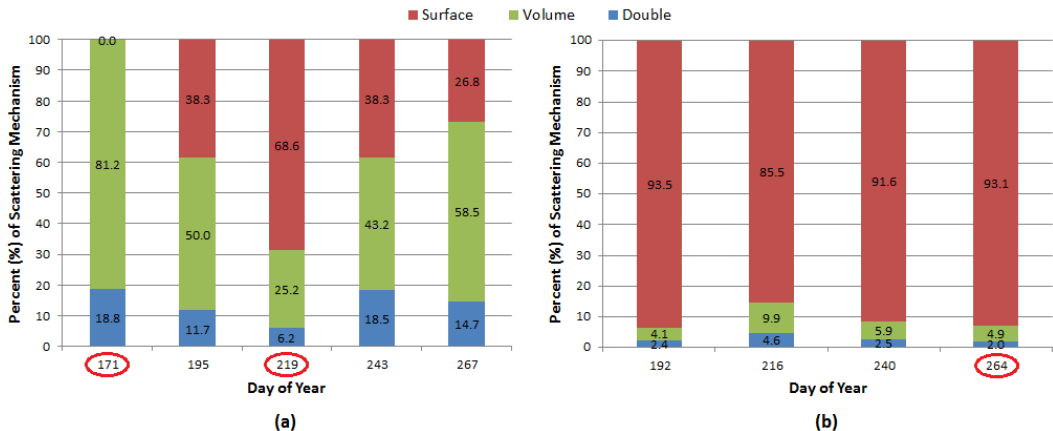
Figure 14. Surface water Freeman-Durden decomposition for ( a ) 41° and ( b ) 26° incidence angles based on RADARSAT-2 fine-quad beam modes. Note that circled days coincide with polarization response plot and Cloude-Pottier decomposition dates.